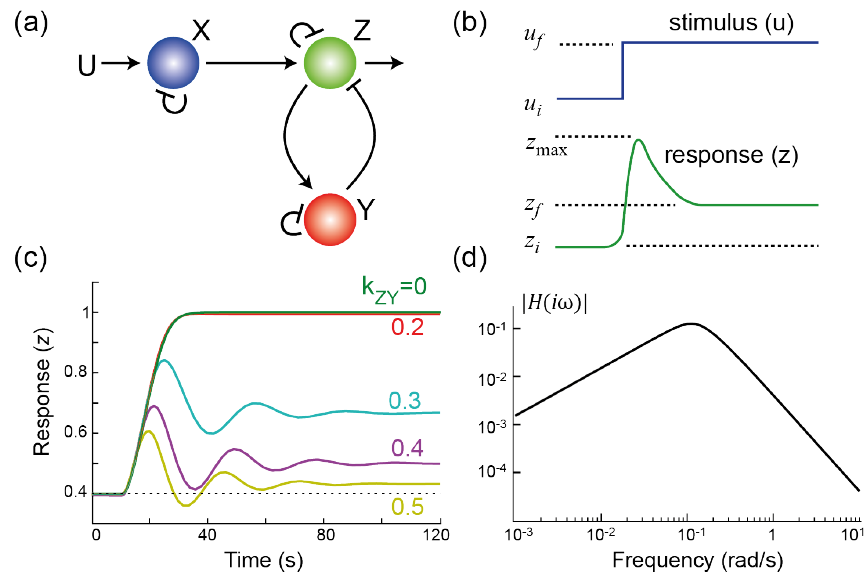
Figure 1. Adaptation through negative feedback. (a) Three node network involving negative feedback regulation through node Y ; (b) This cartoon shows a partially adapting system. As the level of the stimulus increases from its initial ( u ) to final ( u ) level, the i f response shows a biphasic response. It increases from its initial value ( z ), reaches a peak i ( z ) before settling to a final steady-state ( z ). In this case, the system is partially adapting. max f = z It is said to be perfectly adapting if z ; (c) Simulation results of the system in panel i f ( a ) for varying strength of the feedback loop; (d) Frequency response of the system. The slope seen at low frequencies is indicative of integral control. At high frequencies, this drop provides filtering of high frequency